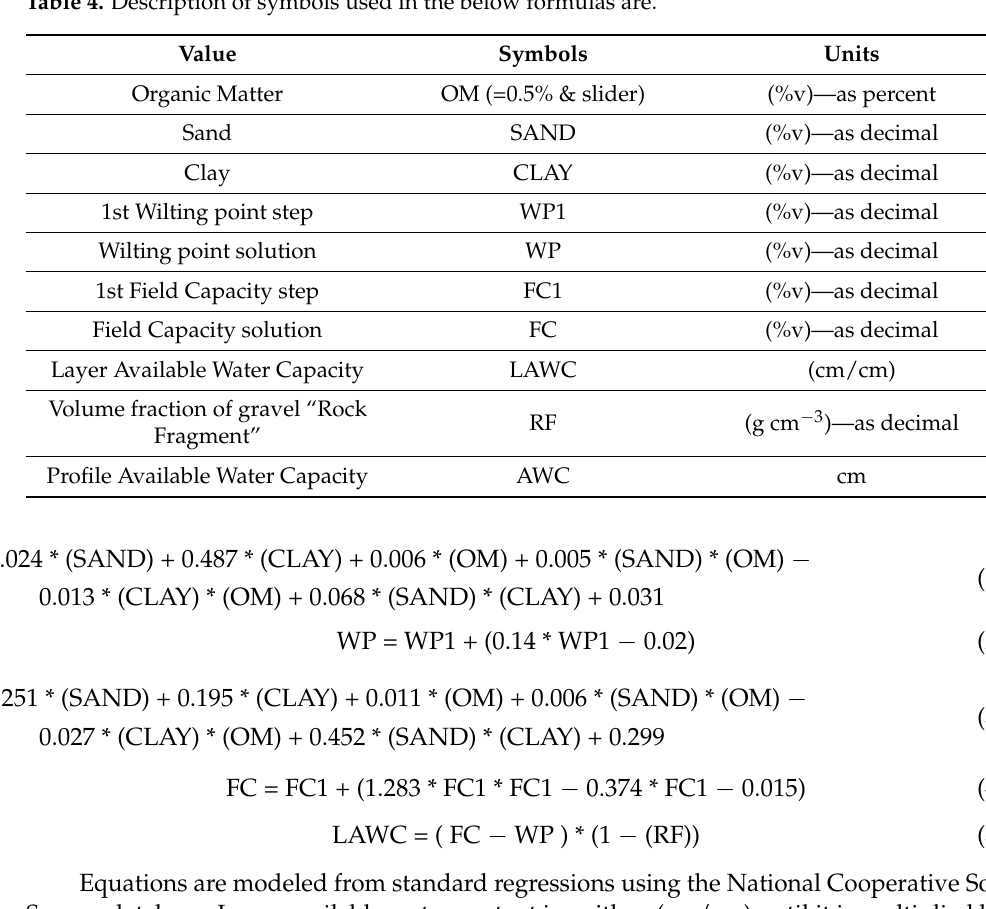
Table 4. Description of symbols used in the below formulas